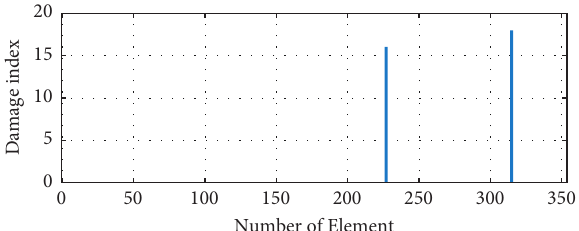
Figure 27: Results of multidamage case D3 using MCA-DI (setback building).